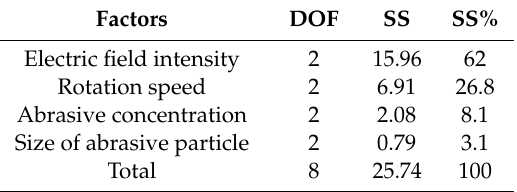
Table 8. ANOVA of surface roughness.